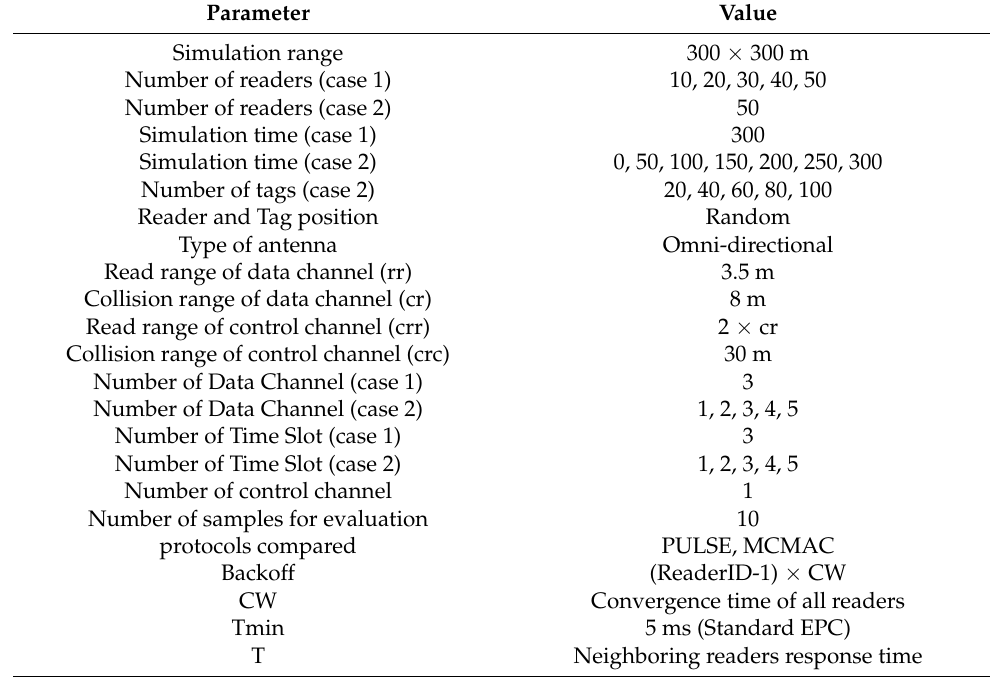
Table 4. Simulation